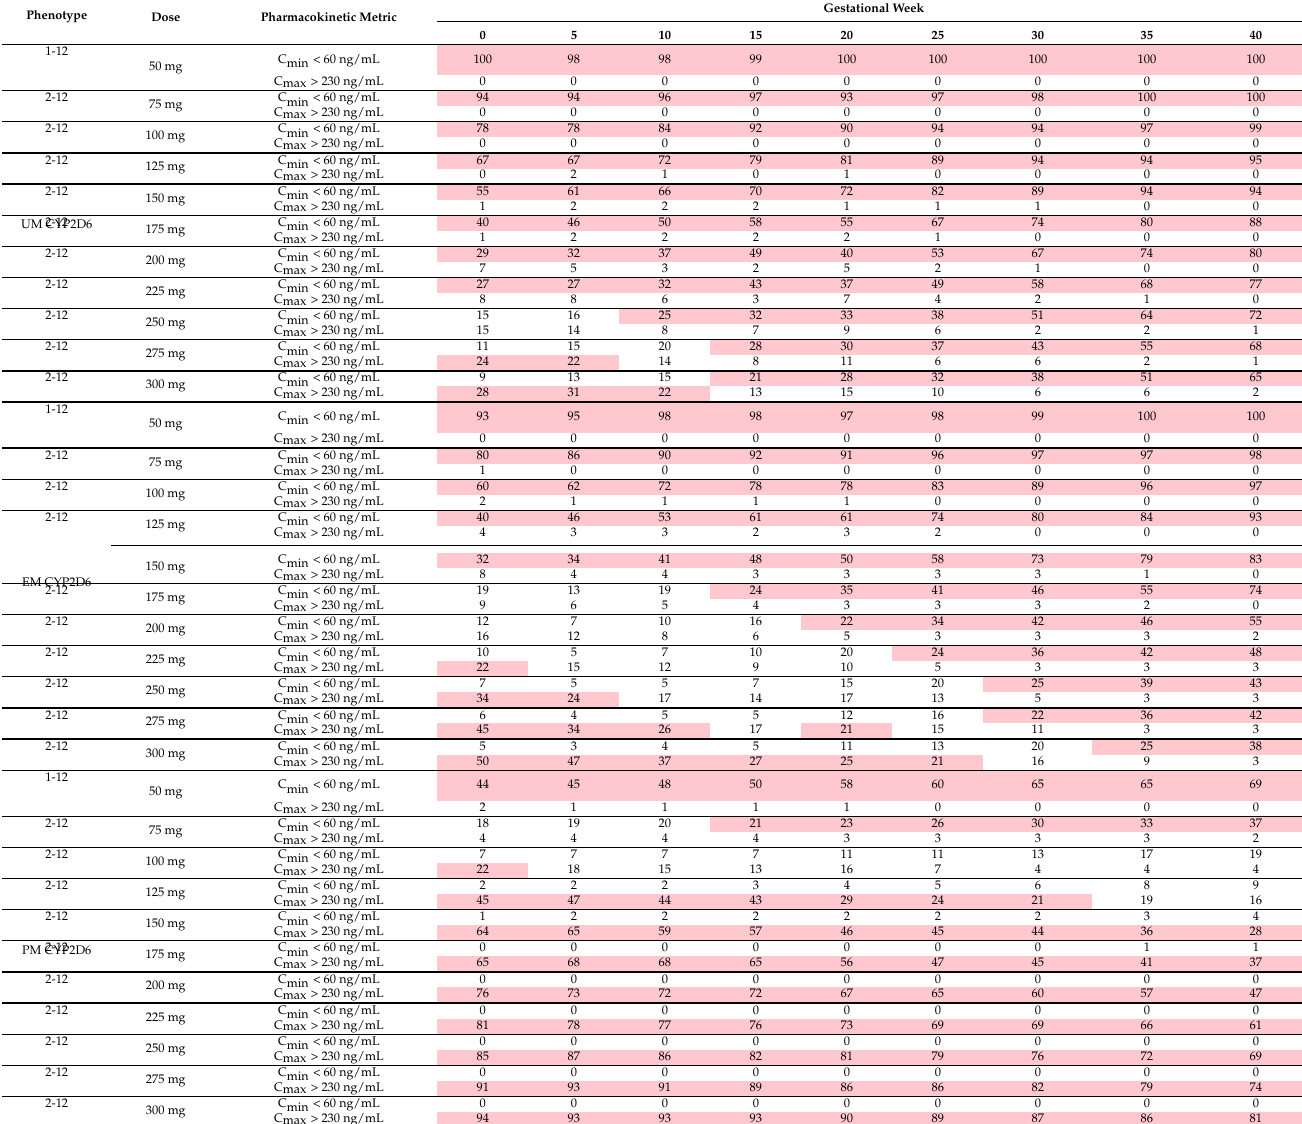
C min , trough umbilical cord concentration; C max , maximum umbilical cord concentration; the red column indicates the percentage of subjects where the trough and peak outside the therapeutic window (60–230 ng/mL) is more than